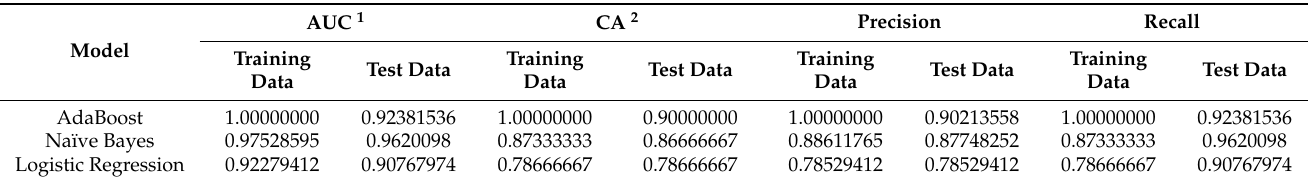
Table 3. Models tested during classification